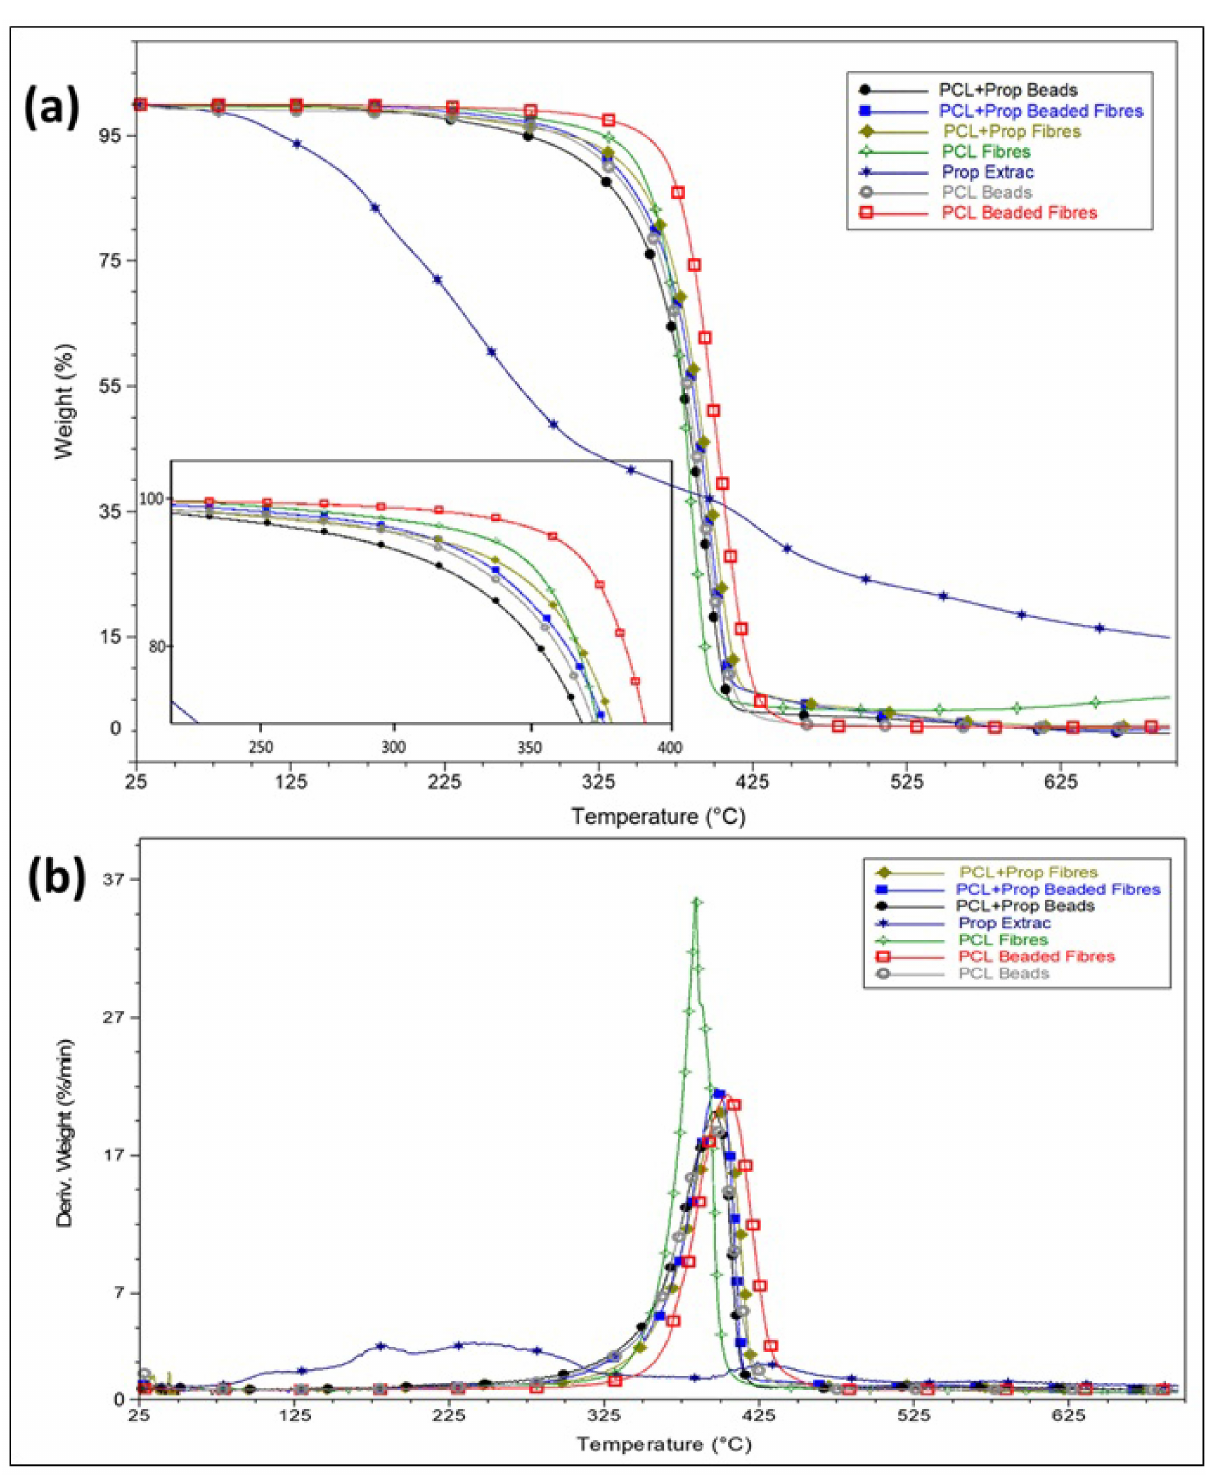
Figure 5. Thermal behaviour: ( a ) TG curves and ( b ) DTG of PCL and PCL + Prop electrospun